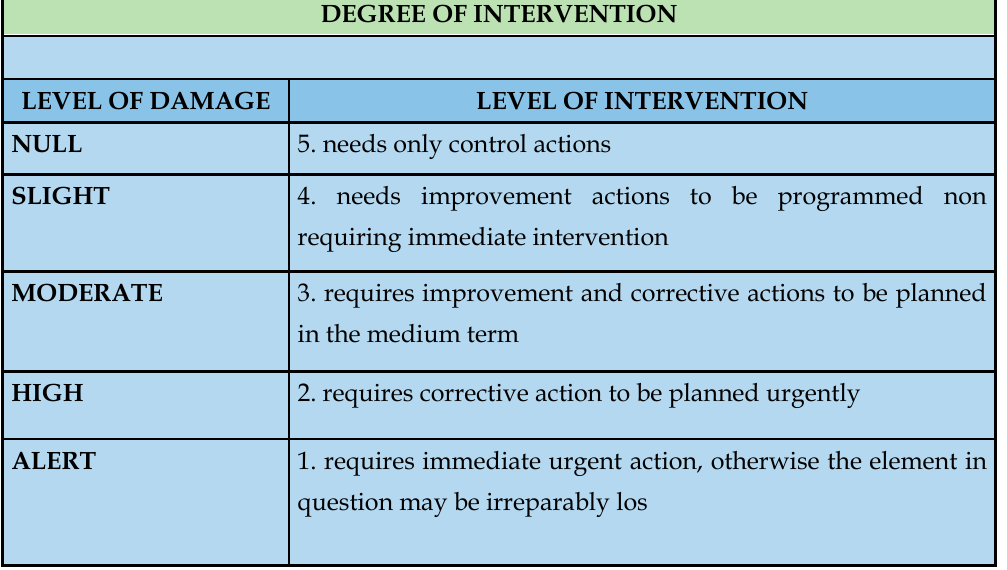
Figure 13. Table illustrating the level of damage identified in SyPEAH for each aspect monitored, i.e., instability, degradation, soil deformation, geology, diagnostic instrumentation, satellite data, and weed vegetation in relation to materials (figure produced with the kind collaboration by A. Petretto).